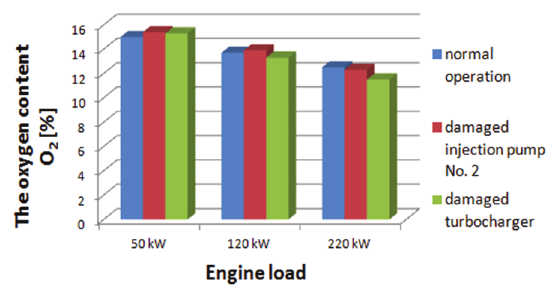
Fig. 3. The influence of the engine load on the oxygen O 2 [%] content indicated by the analyzer for various engine states